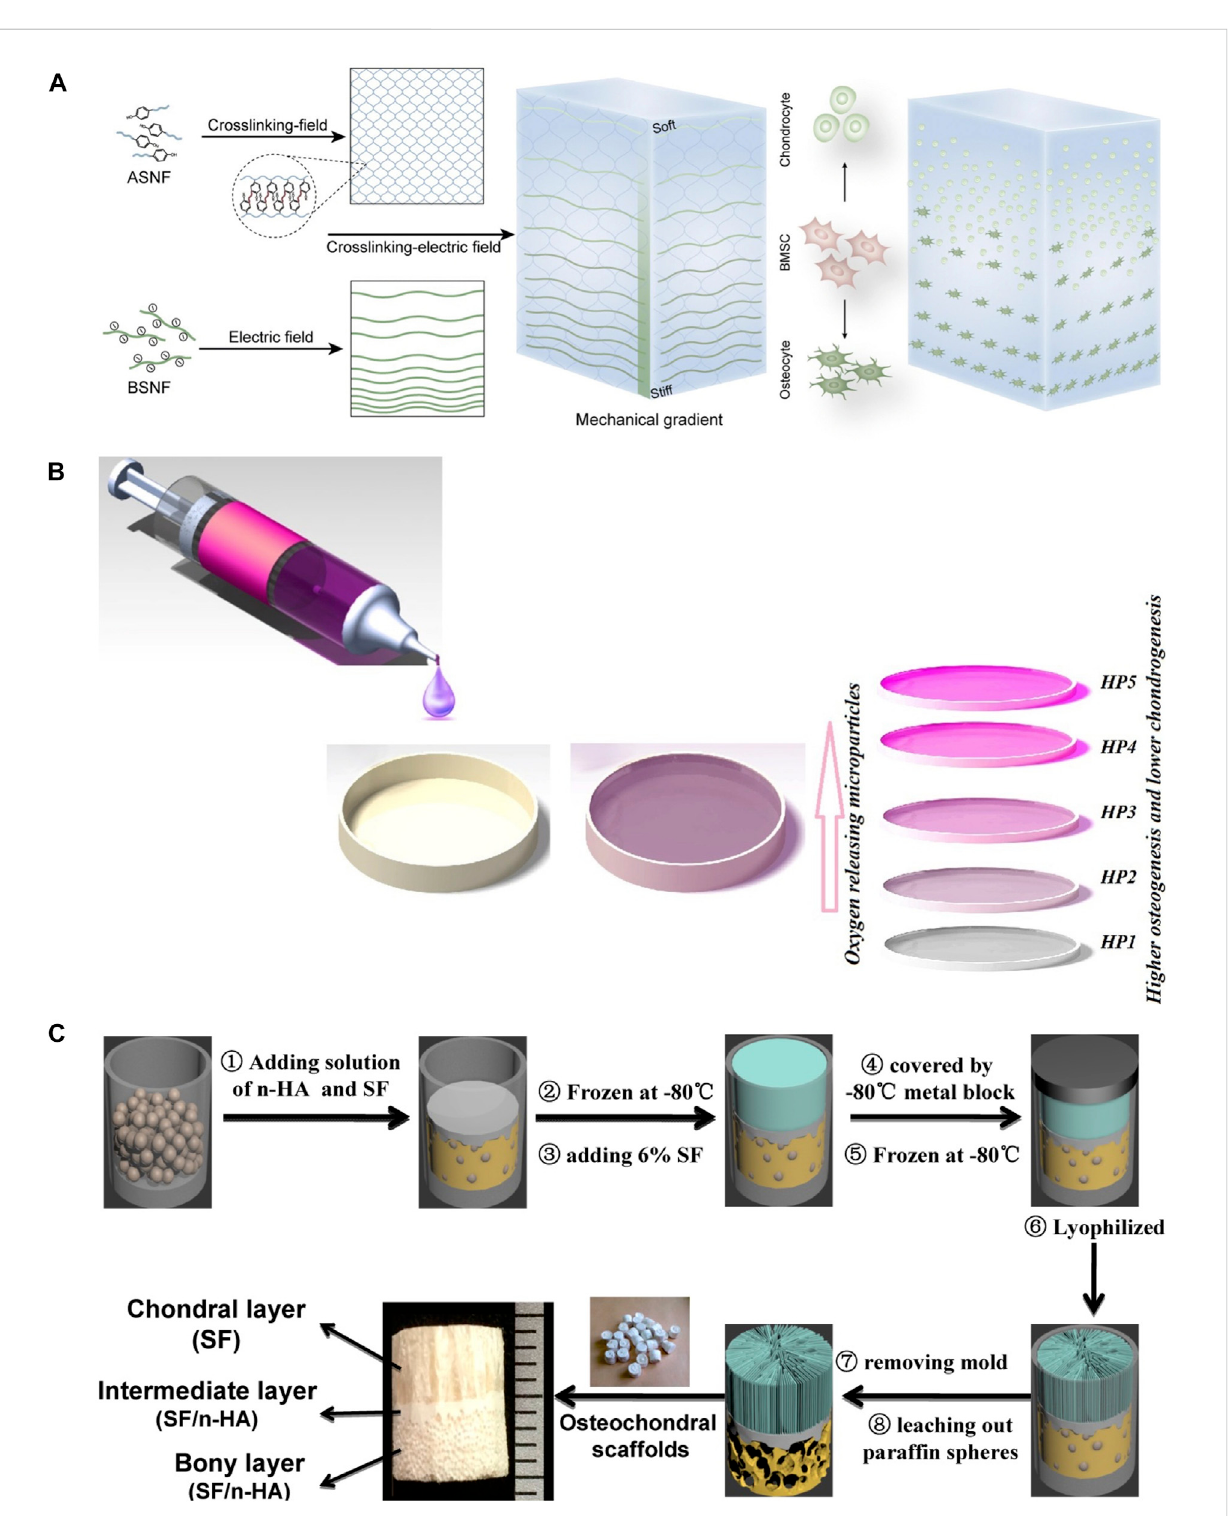
FIGURE 6 Mechanical gradient of silk protein hydrogels. (A) Electric fi eld and gelation of ASNF-induced gradient distribution of BSNF. (B) Gradient distribution of polylactic acid (PLA) and calcium peroxide (CPO) microparticles in silk fi broin hydrogel through a gradient mixing chamber. (C) Integrated tri-layer osteochondral tissue engineering scaffold composed of the upper SF layer with oriented structure, dense intermediate SF/HA layer, and bottom SF/HA layer with porous structure through paraf fi n leaching. Adapted with permission from ref (Ding et al., 2014; Xu et al., 2020; Khorshidi et al., 2021) Copyright 2021